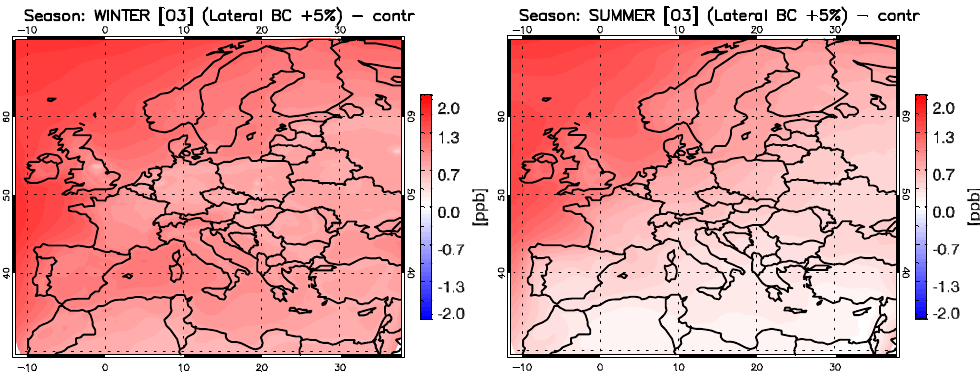
Figure 11. Sensitivity study with 5% O 3 increase at the lateral boundary conditions. The plots show changes in seasonal average surface ozone concentrations for the winter (left) and the summer (right) season.